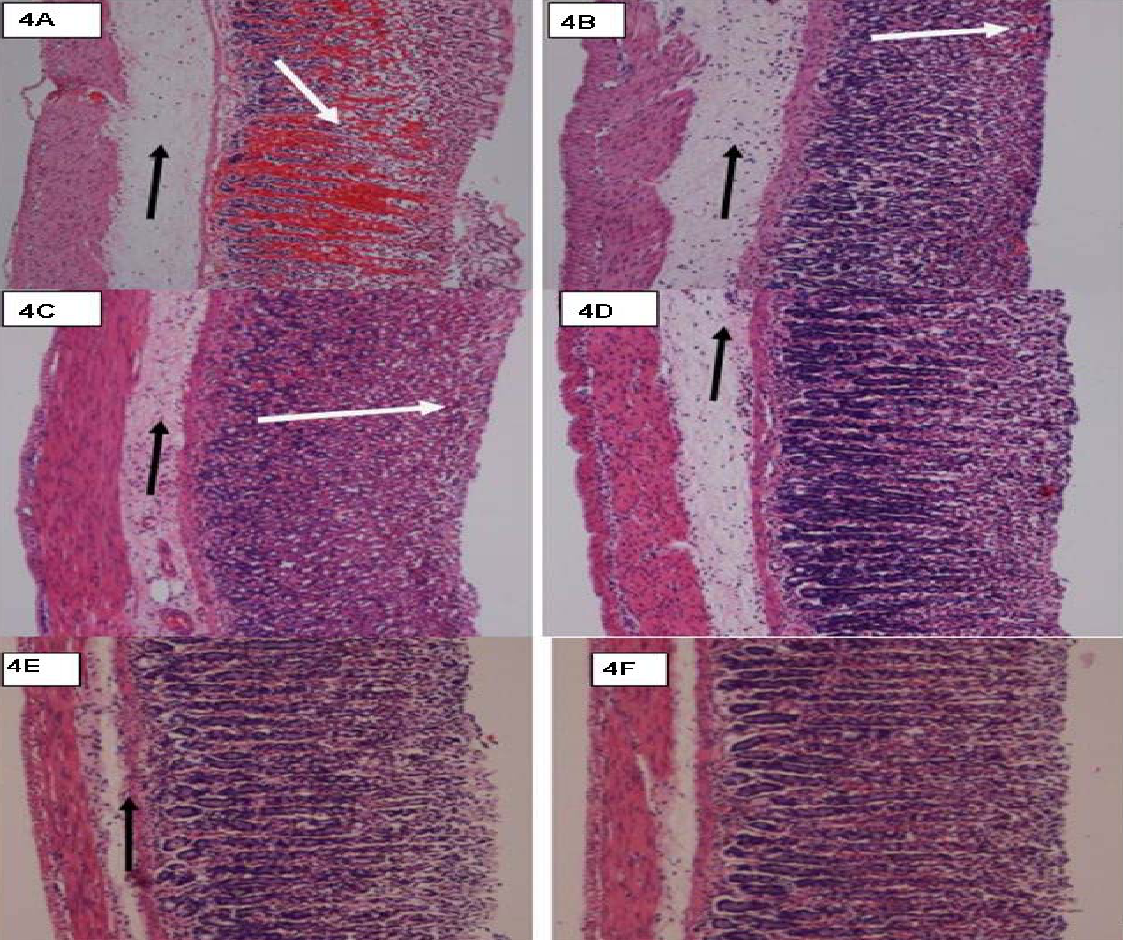
Figure 4. Histological view of the ethanol-induced gastric mucosal damage in rats. ( 4I ) Rats pre-treated with 5 mL/Kg of distilled water (ulcer control). There is severe disruption to the surface epithelium and necrotic lesions penetrate deeply into mucosa (white arrow) and extensive edema of submucosa layer and leucocyte infiltration are present (black arrow); ( 4II ) Rats pre-treated with omeprazole (20 mg/Kg). Moderate disruption of the surface epithelium mucosa is present (white arrow) but deep mucosal damage is absent. Submucosal edema and leucocytes infiltration (black arrow); ( 4III ) Rat pre-treated with CuLBS (30 mg/Kg) and then followed with ethanol (CuLBS-Et, 30 mg/Kg). Mild disruption of surface epithelium is present but deep mucosal damage is absent. Submucosal edema and leucocytes infiltration (black arrow); ( 4IV ) Rat pre-treated with CuLBS (60 mg/Kg) and then followed with ethanol (CuLBS-Et, 60 mg/Kg) Very mild disruption of surface epithelium is present but deep mucosal damage is absent. Submucosal edema and leucocytes infiltration (black arrow); ( 4V ) Rats pre-treated with CuLBS-alone (60 mg/Kg).There are no disruption to the surface epithelium with no edema and no leucocytes infiltration of the submucosal layer; ( 4VI ) The normal rats rats pre-treated with CMC alone. There is no disruption to the surface epithelium with no edema and no leucocytes infiltration of the submucosal layer (H & E stain;